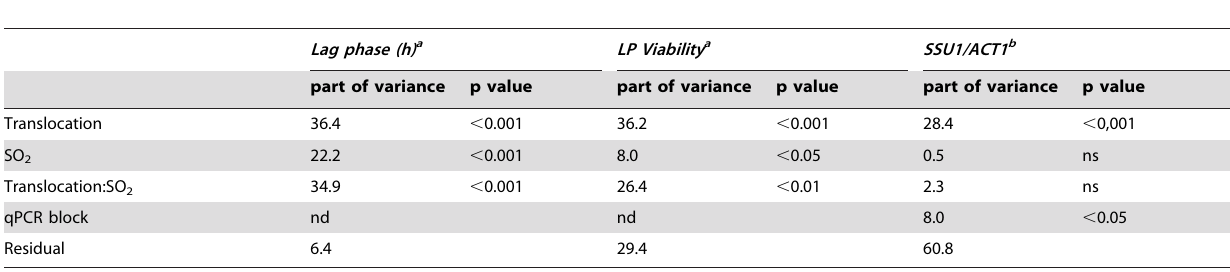
Table 2. Analysis of variance of lag phase, viability change, and SSU1 expression according to the translocation and total SO 2 concentration in the